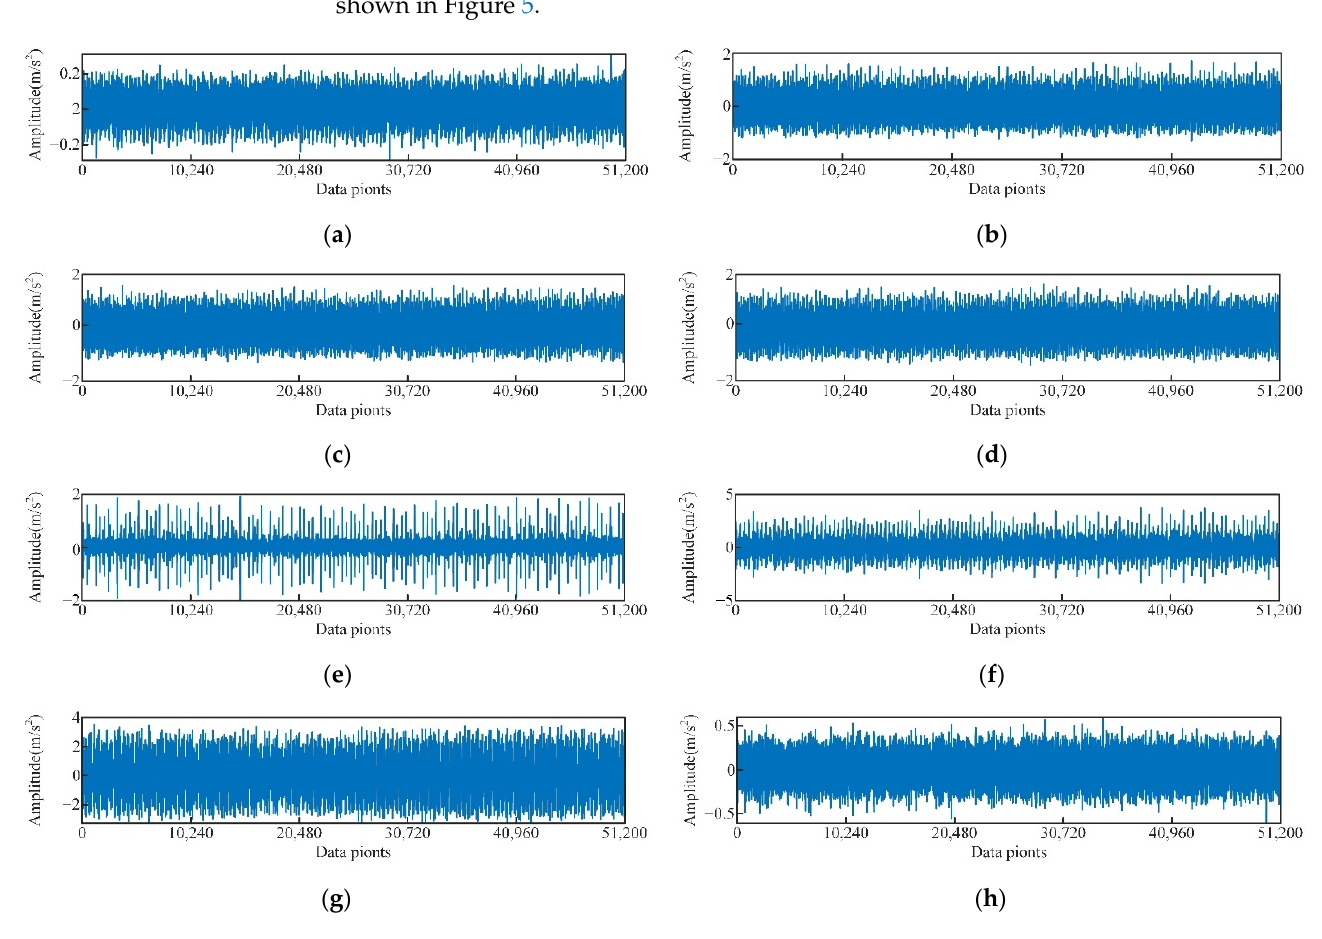
Figure 5. Time domain diagram of vibration signals of different types of rolling bearings, ( a ) 0HP load normal, ( b ) 0HP load inner ring fault diameter is 0.1778 mm, ( c ) 1HP load inner ring fault diameter is 0.1778 mm, ( d ) 2HP load inner ring fault diameter is 0.1778 mm, ( e ) 0HP load inner ring fault diameter is 0.3556 mm, ( f ) 0HP load inner ring fault diameter is 0.5334 mm, ( g ) 0HP load outer ring fault diameter is 0.1778 mm, ( h ) 0HP load rolling element fault diameter is 0.1778 mm.